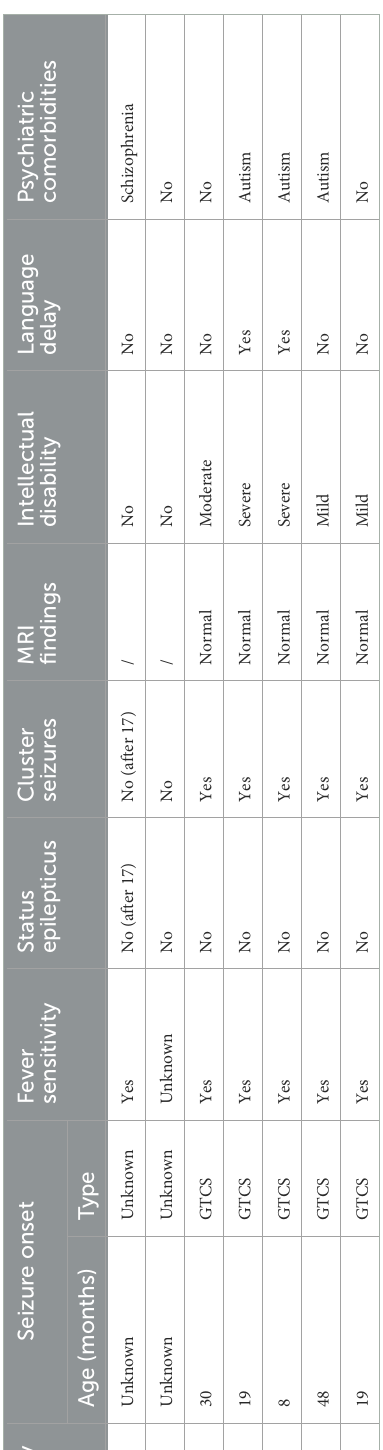
Sequencing result and analysis of